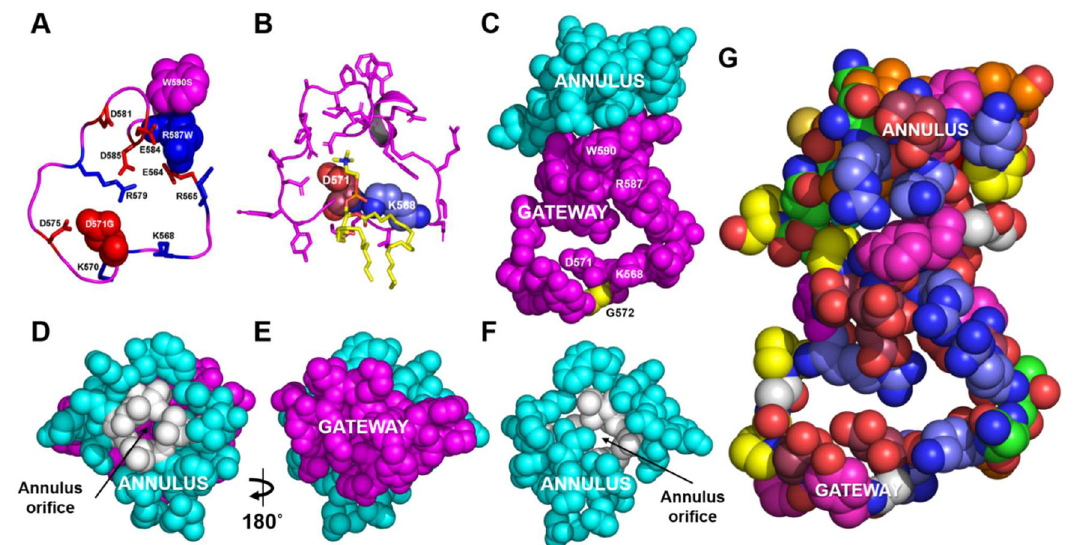
Fig.2|Structuraldetailsofthegateway/annuluscomplex.A , B Thebackboneof the gateway (magenta). A The basic (blue, stick) and acidic (red, stick) amino acid residues of the gateway (residues 564 – 592, magenta) from the ABCA1 structure determinedbycryo-EM 13 .Thethreeaminoacidresiduesinthegatewayknowntobe mutated in Tangier disease (four point mutations in total) are shown in the space- fi lling mode. B The POPC molecule (yellow stick) forms salt-bridges to residues D571andK568(space- fi llingredandblue,respectively)inthe1.9 µ secframeduring coarse-grained molecular dynamics (CGMD) modeling of unmutated ABCA1. All side chains but residues D571 and K568 are magenta stick. C The gateway (magenta)/annulus(cyan)complex.Residuesof theelongated hydrophobictunnel that lie within 10Å of any gateway residue form the annulus domain (residues 69,